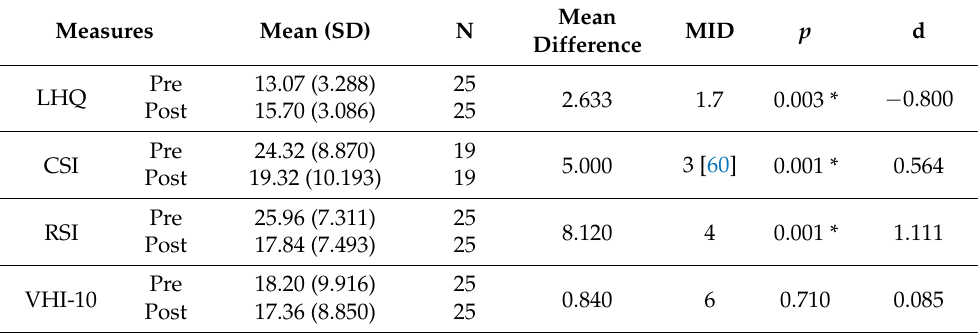
Table 9. Mean, mean difference, and effect sizes (Cohen’s d: small = 0.2; medium = 0.5; large = 0.8). MID, minimal clinically important difference; (*), significant at p <